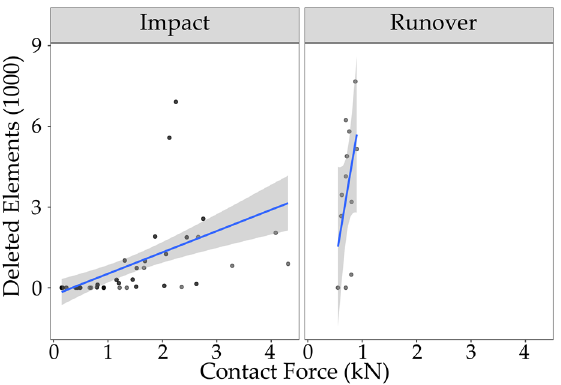
Figure 15. Relationship between deleted elements and the contact force. Left: Impact loading conditions; right: run-over loading conditions.